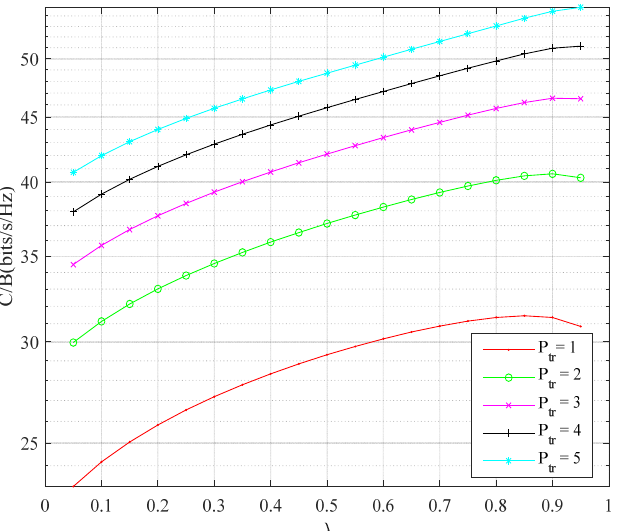
Figure 7. Average channel capacity of the system under different transmission powers and different constellation priority parameters.